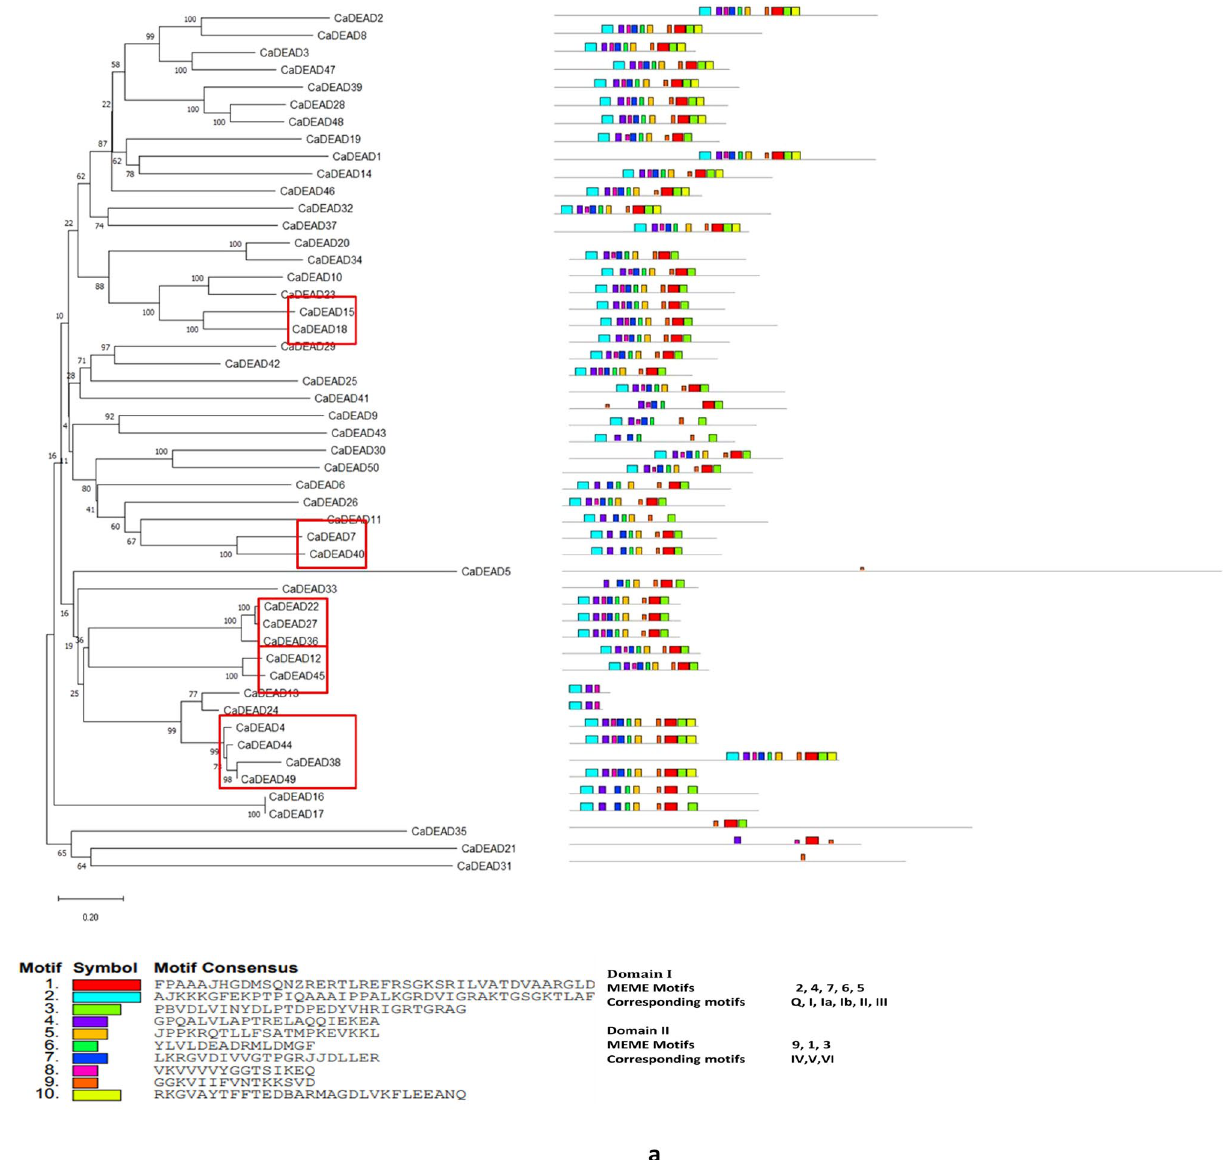
Figure 5. The distribution of conserved motifs in the identified RNA helicase proteins in chickpea. The horizontal coloured boxes indicate conserved motifs within each protein with description of the consensus sequences present at the motifs, described below the figures. Neighbor-joining tree of the proteins is shown on the left. Numbers at the nodes indicate bootstrap values. Duplicate gene pairs are enclosed in red colored